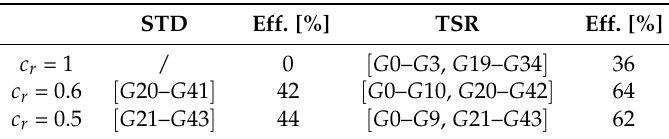
Table 4. Efficacy assessment of both approaches for the G16 standard for various damping parameters. Efficiency is defined as the ratio of valid unbalance range and total unbalance range for said tolerance class [ G 0– G 50 ]